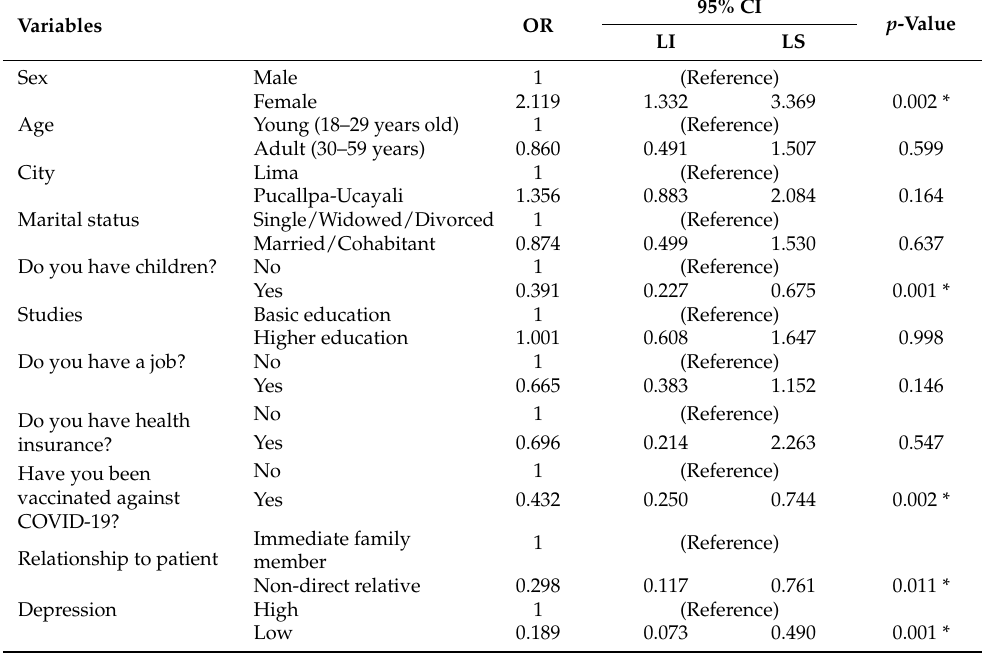
Table 4. Multivariate analysis according to the quality of life of the caregiver of post-COVID-19